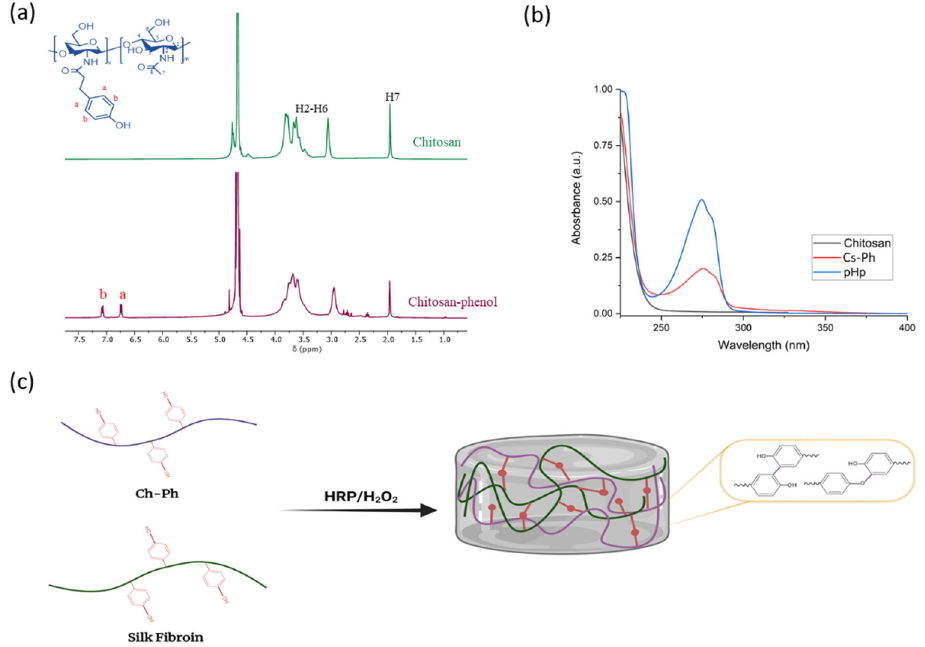
Figure 1. ( a ) 1 H NMR spectra of the Cs-Ph conjugate and unmodified Cs; ( b ) UV-vis spectra of Cs-Ph, unmodified Cs, and pHp; ( c ) Schematic illustration of Cs-SF hydrogel through an enzyme-mediated crosslinking method using HRP and hydrogen peroxide (H 2 O 2 ).